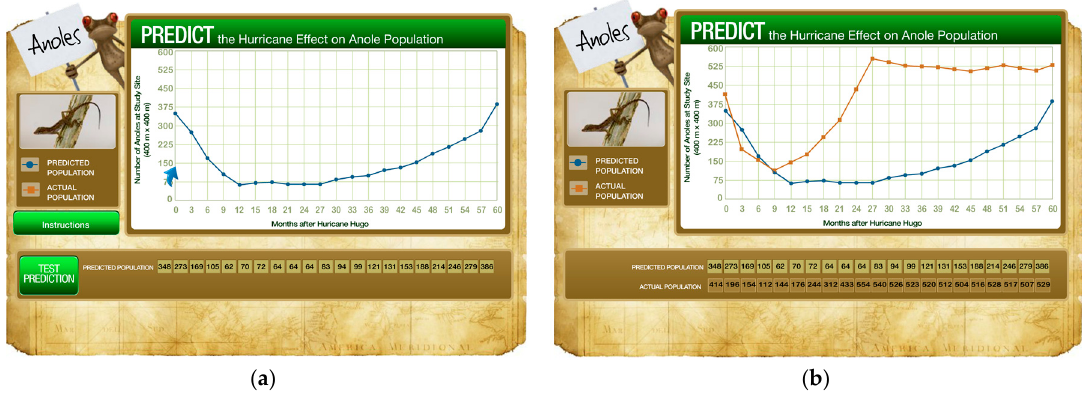
Figure 3. Screenshots of the process of making a prediction. ( a ) The student has drawn out a prediction of the anole population numbers each month for 60 months. ( b ) The student has clicked on Test Prediction to see a graph of the interpolated population numbers collected by Luquillo scientists after Hurricane Hugo.